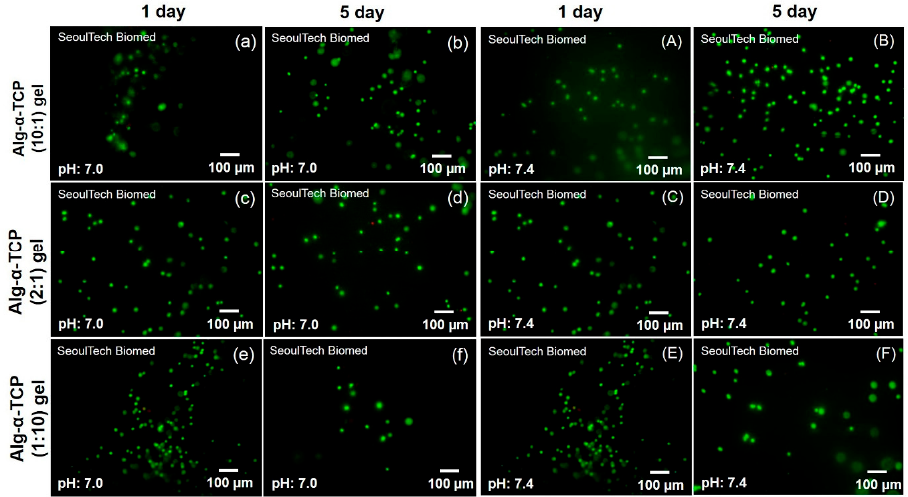
Figure 7. Fluorescence microscopy images of the live and dead MC3T3 cells inside the Alg- α -TCP hybrid gels (1:10, 2:1 and 10:1) at pH 7.0 ( a – f ) and pH 7.4 ( A – F ) using Calcein AM and EthD-1 kits.